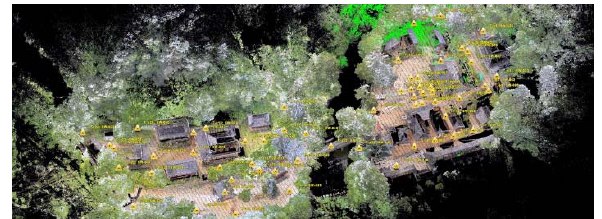
Figure 3. Field scan positions for the Magoksa Temple The three-dimensional shape of the temple was generated by registering, merging, and noise filtering the scanning data. Shape registering was conducted by selecting at least three corresponding points from each point cloud. Subsequently, all registered point clouds were merged and filtered to complete one object model. Figure 4 shows the point cloud and texture mapping images of the Magoksa Temple obtained by merging and filtering the laser scanning data. Notably, the overall three- dimensional shape reflected the vertical geometry of the building;